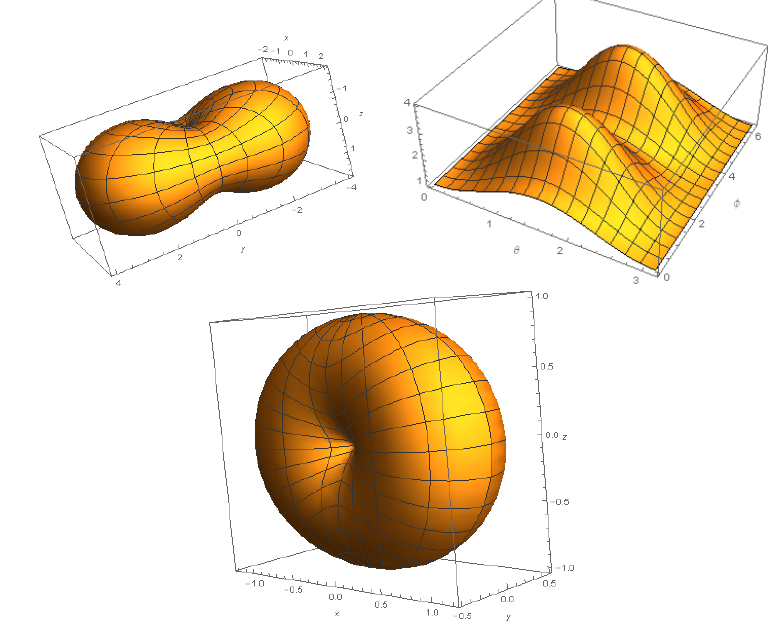
Figure 7: model class 5. left, right: contour surface of the density and function H ( α 1 = θ , α 2 = φ ) in the case a = 2, b = 1 . bottom: contour surface in the case a = −1, b =